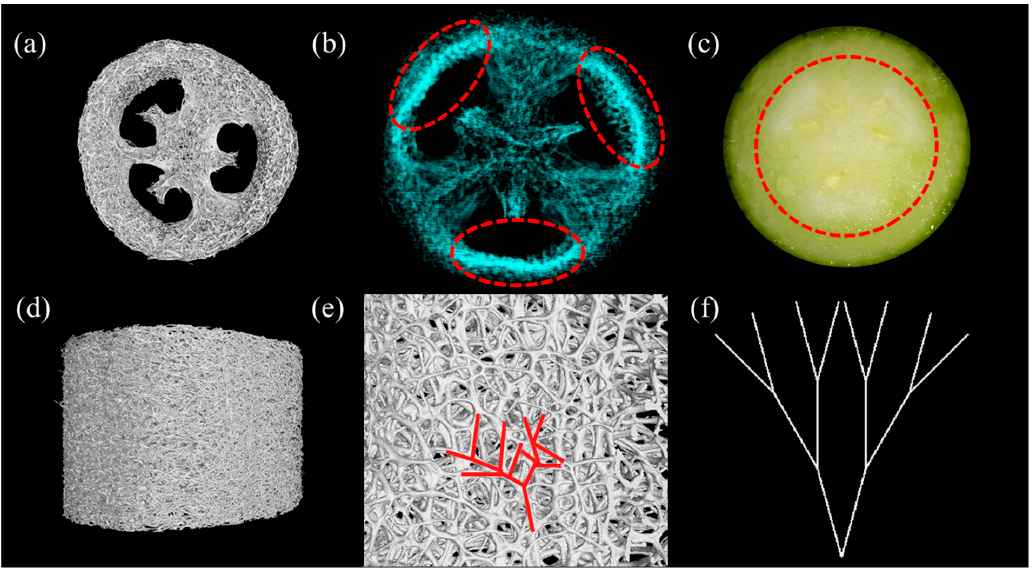
Figure 3. The micro-computed tomography (micro-CT) scan picture of luffa sponge: ( a ) Cross section of luffa sponge; ( b ) Three high-density areas of luffa sponge; ( c ) Cross section of nature luffa; ( d ) Vertical section of luffa sponge; ( e ) Texture of I layer; ( f ) Simplified structure of I layer.